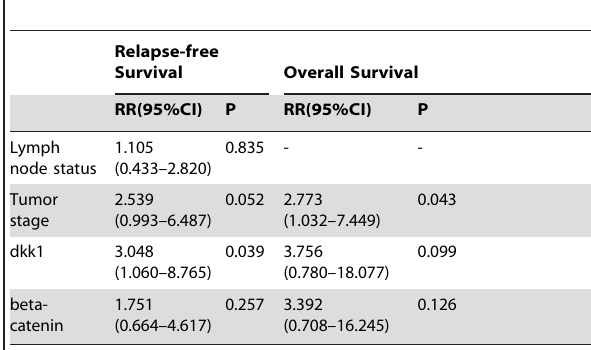
Table 3. Univariate analysis of prognostic factors for breast cancer patients.